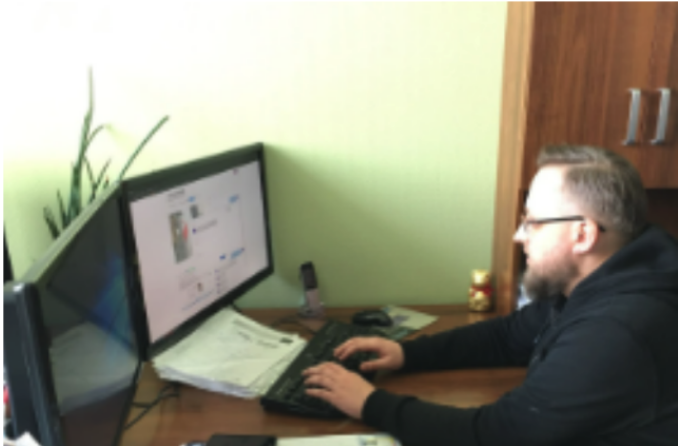
Figure 6. The employee’s last resort—a videocall with the expert (the expert’s workplace and communication application